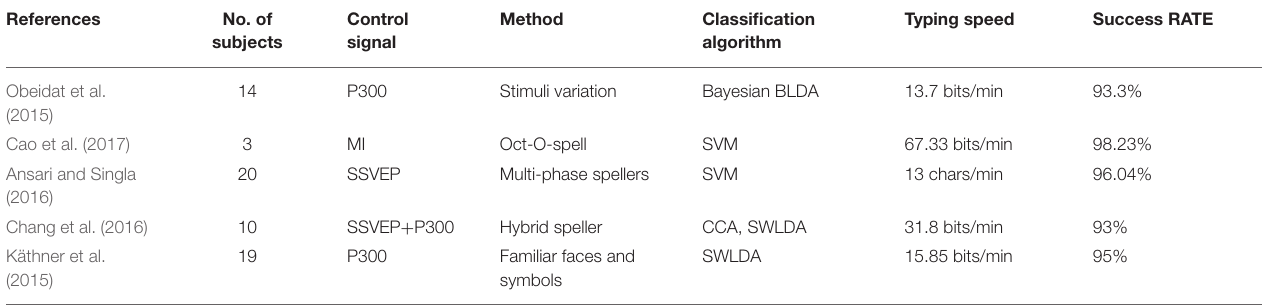
TABLE 5 | Summary of EEG-based BCI speller